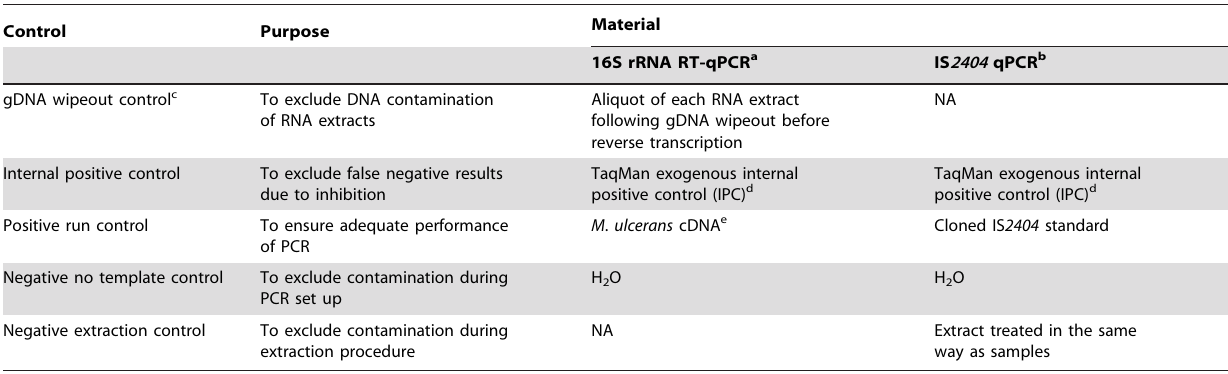
Table 4. Controls applied in 16S rRNA RT/IS 2404 qPCR.